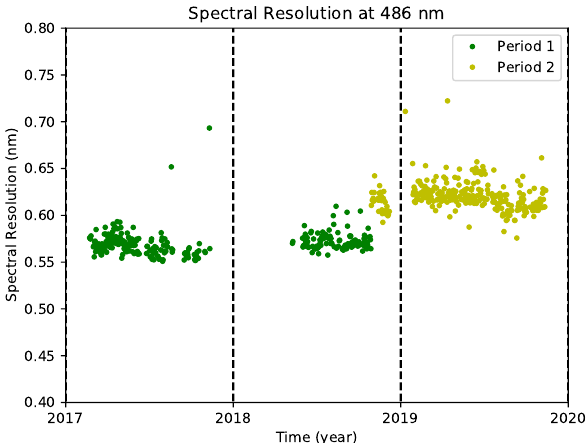
Figure 3. The instrument’s spectral resolution in the spectral window centered at 486 nm and for all the measurements periods. Each color identifies a period characterized by a time-constant spectral